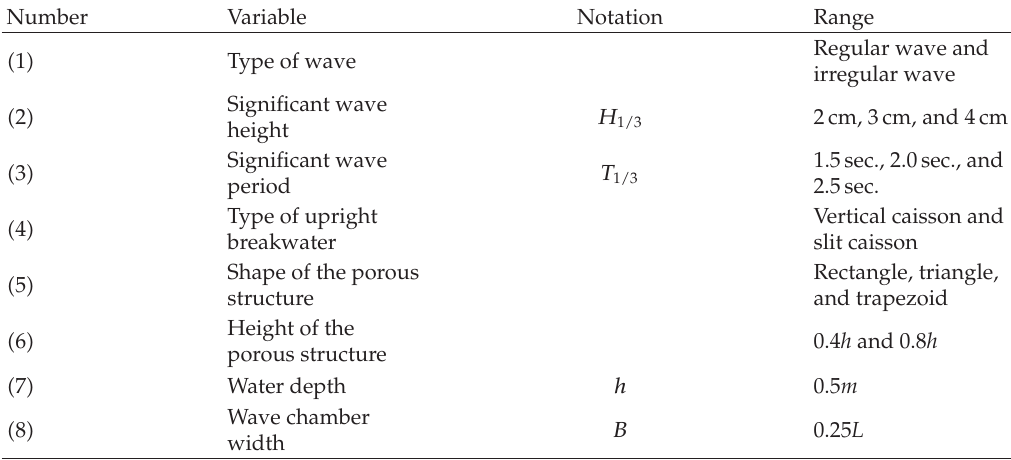
Table 1: Numerical